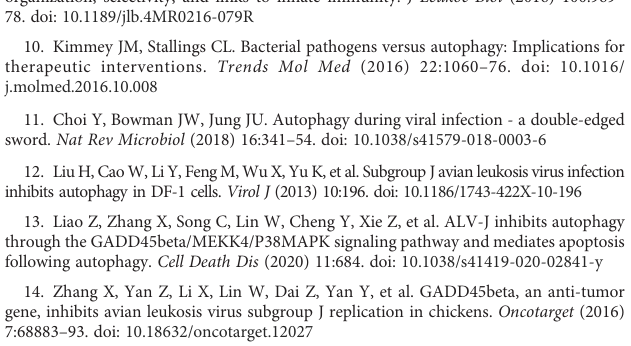
SUPPLEMENTARY FIGURE 3 Bioinformatics analysis of candidate CH25H-interacting proteins. (A) Subcellular localizationofcandidateCH25H-interactingproteinsasannotatedbytheUniProt database. (B) Biological process analysis of candidate CH25H-interacting proteins. (C) Molecular funtion of candidate CH25H-interacting proteins. (D) Pathway analysis of candidate CH25H-interacting proteins. SUPPLEMENTARY FIGURE 4 The ef fi ciency of overexpression and interference. TSG101 (A) , CHMP4B (B) , RPL23